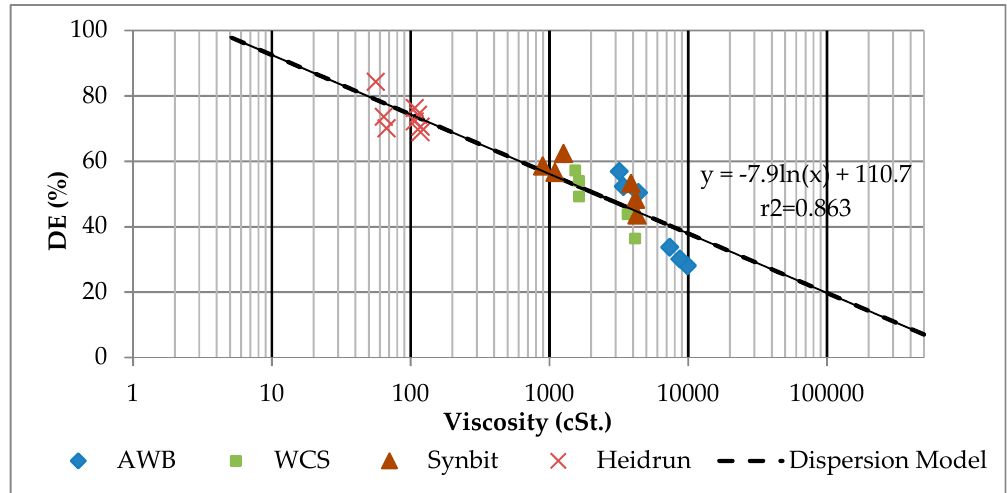
Figure 6. A plot of the effectiveness of chemically enhanced dispersion (DE%) as a function of oil viscosity. Experiments were conducted in spring and summer with fresh and weathered oils (Table S1). A dispersion model was fitted to the data points that represent four different oil types. DE (%) decreases with the increasing viscosities of oils, but effectiveness better than natural dispersion.